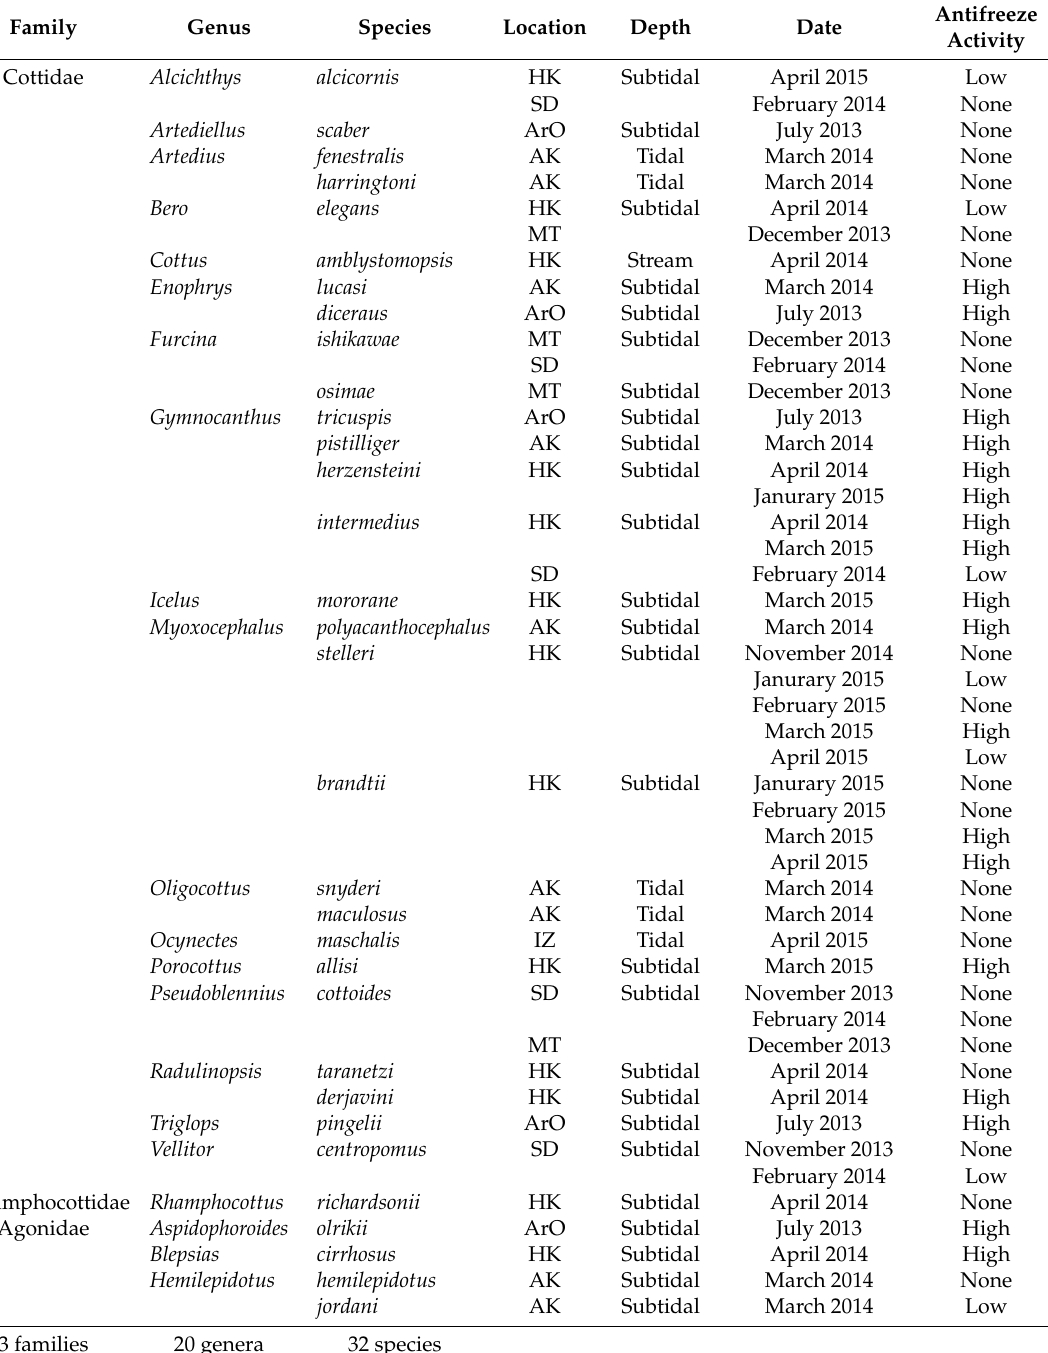
Table 3. Sample information and antifreeze activities in Cottoidea. ArO: Arctic Ocean, AK: Alaska, HK: Hokkaido, MT: Mutsu, SD: Sado Island, IZ: Izu.